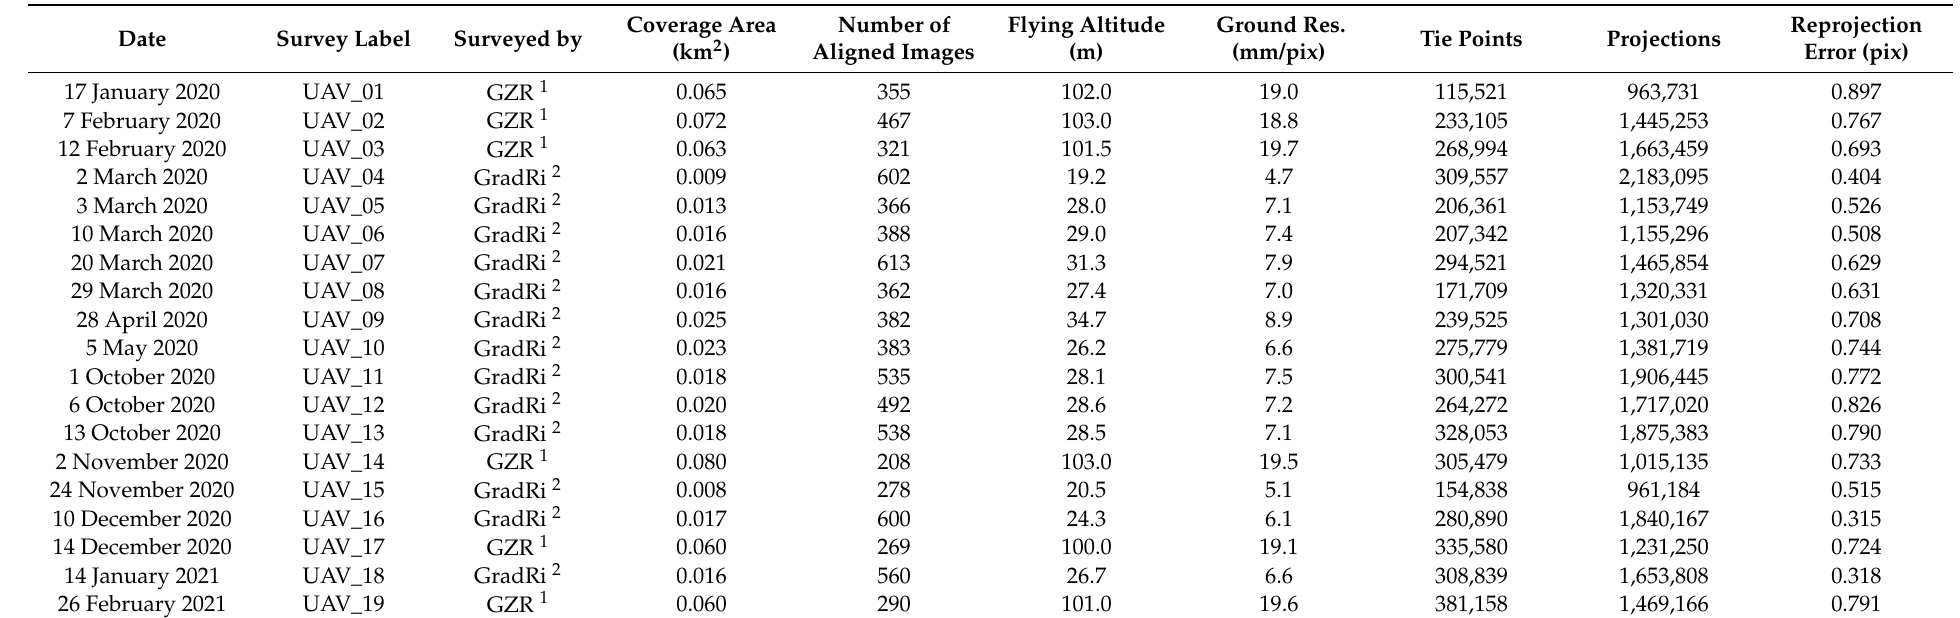
Table 2. Survey data from Agisoft